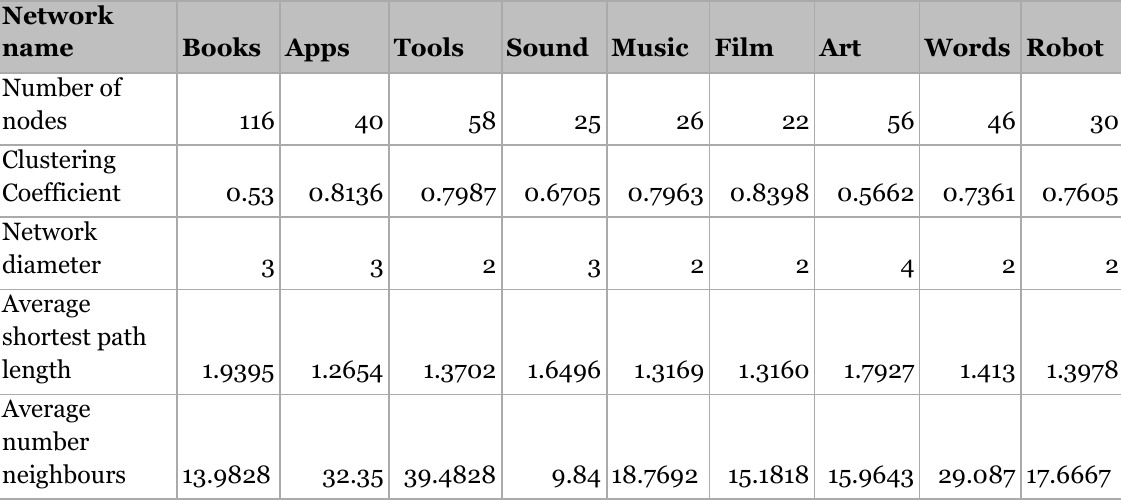
Network Properties in the Case of the Indirect Relations Established Within Each Selected Community